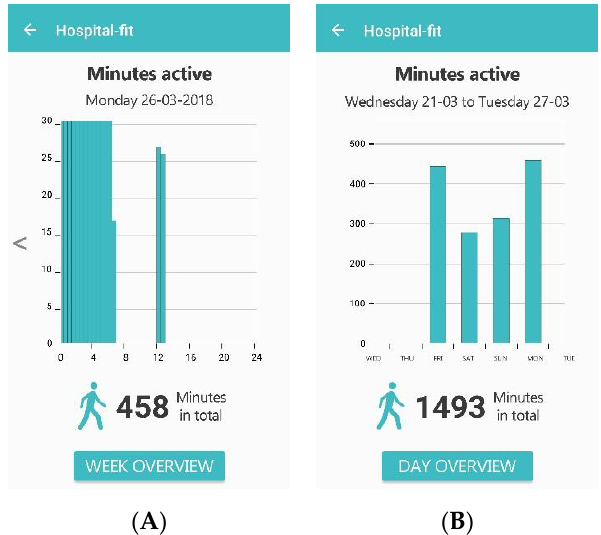
Figure 2. Overview of the total number of minutes spent standing and walking per day ( A ) and per week ( B ).